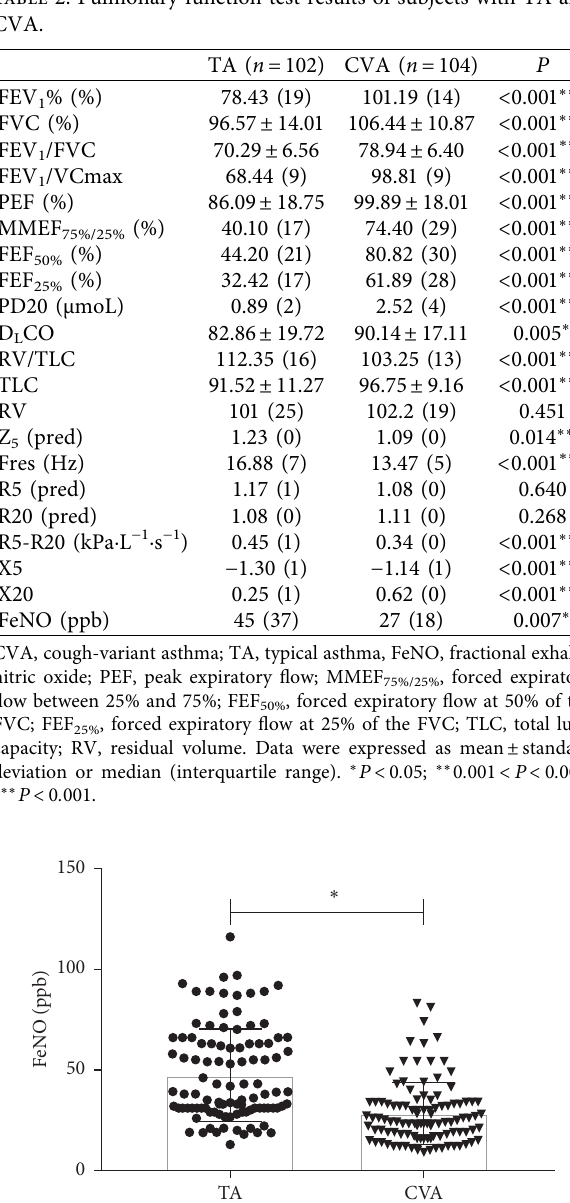
Figure 1: Comparison of FeNO level between the TA and CVA subjects, ∗ P < 0 . 05, compare with